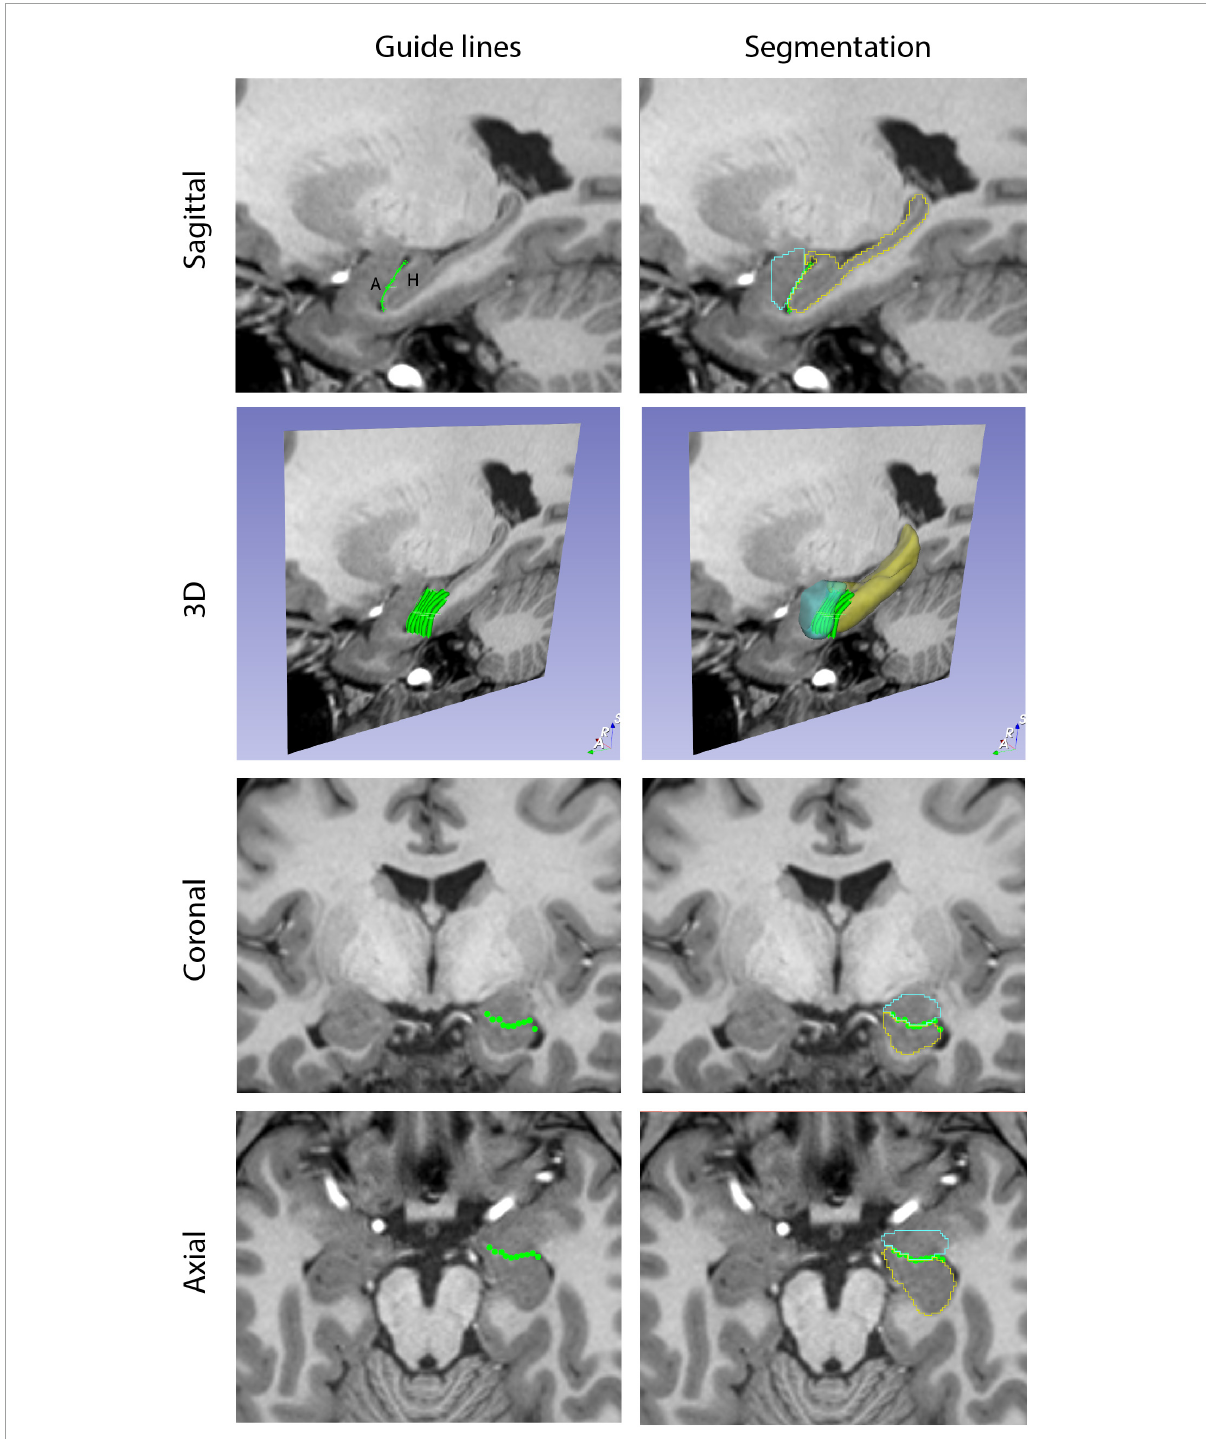
FIGURE2 Guide Markup tool. The Guide Markup tool provides a means by which overlay lines can be drawn on one view of the brain (e.g., sagittal) to guide segmentation in another view (e.g., coronal). Guide lines are shown in the left column. In the upper left image, a guide line is drawn between the amygdala (A) and the hippocampal formation (H). This is repeated for a number of sagittal sections to produce a series of parallel lines in the 3D perspective. When viewed in the coronal and axial planes, the transects of these guide lines are visualized as individual dots that together generate an estimate of the border between the amygdala and hippocampal formation. The right column shows the resulting segmentations of these two structures (amygdala in teal, hippocampal formation in yellow) along with the guideline